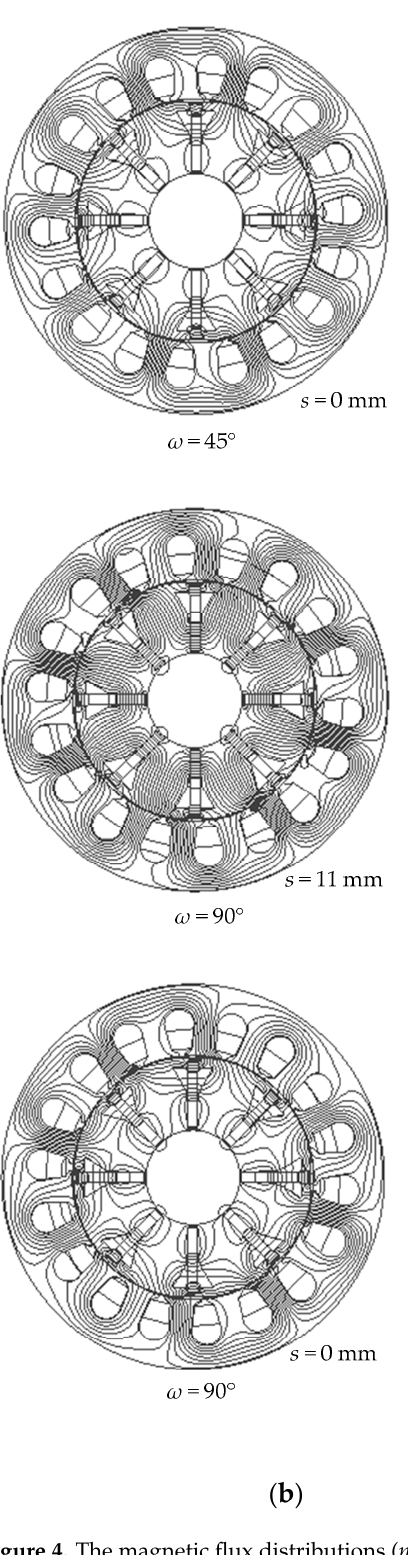
Figure 4. The magnetic flux distributions ( n = 1500 r/min): ( a ) the no-load distribution; ( b ) the load distribution with different angle ω .